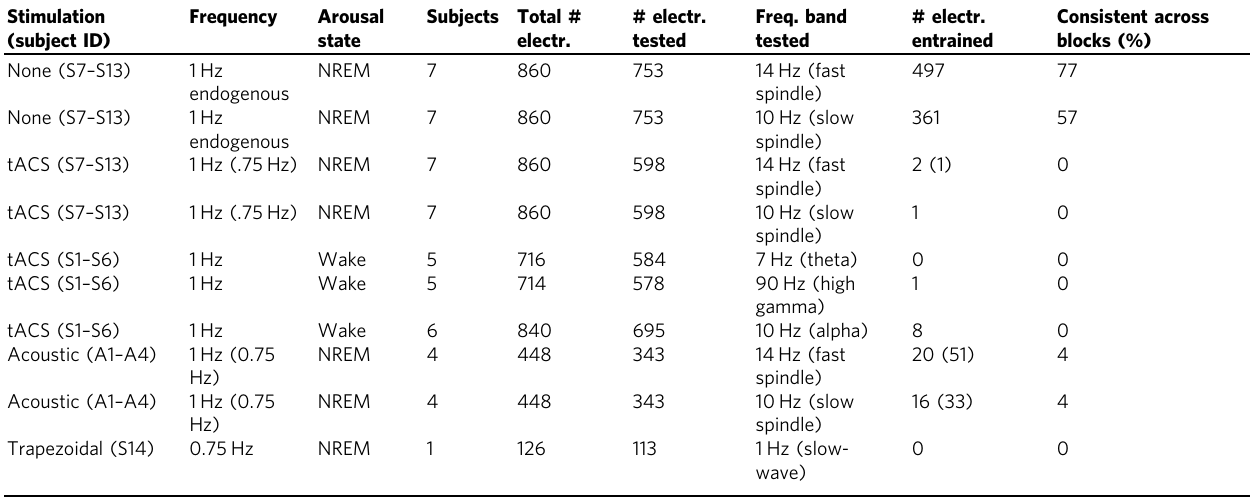
Table 1 Summary of PAC results across all subjects and conditions tested Stimulation (subject ID)